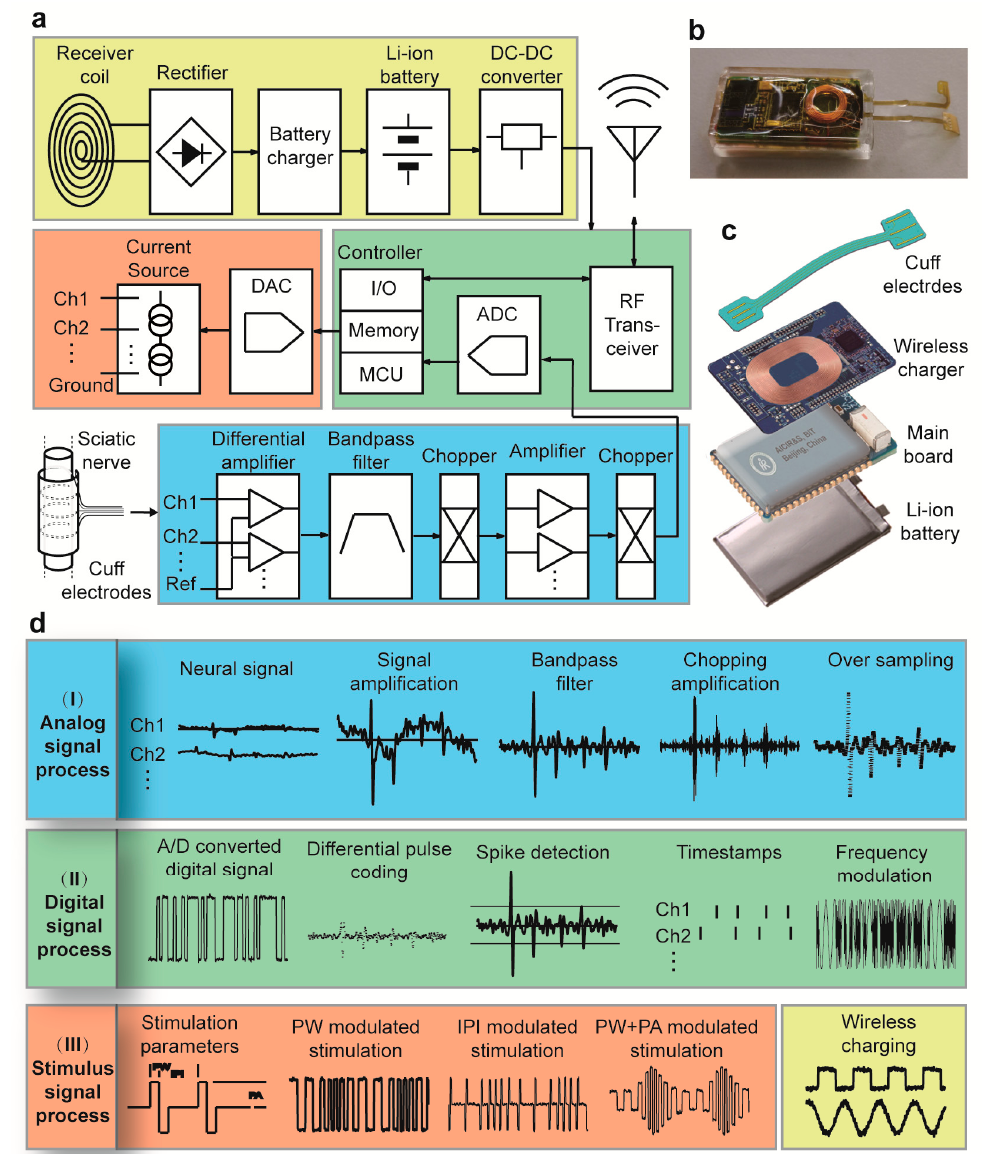
Figure 1. The system block diagram, photograph, 3D assembly, and signal processes of the implantable wireless neural interface microsystem (Neurobits). ( a ) The system block diagram of Neurobits, which consists of an analog signal acquisition unit, a digital signal process unit, a stimulation unit, and a wireless charger. ( b ) Photo of Neurobits. ( c ) Three-dimensional view of the system assembly, consisting of a cuff electrodes array, a wireless charger board, a main board, and a Li-ion battery. ( d ) Diagram showing how different signals are processed inside Neurobits (I, II, III). (I) In analog signal processes, the neural signal from electrodes is amplified and band-pass filtered before passing through a chopper amplifier to reduce internal offset voltage and low-frequency noise. Finally, the analog signal is oversampled to decrease noise and converted into a digital version. (II) In digital signal processes, the signal is encoded using the differential pulse coding method to reduce bit flow. Neurobits is also capable of detecting neural spikes and recording their timestamps. The coded raw signal or spike timestamps are wirelessly sent out through the RF transceiver using the frequency modulation method. (III) In stimulus signal processes, stimulation parameters are remotely set and sent wirelessly to Neurobits, which generates three different types of stimuli according to these parameters, i.e., pulse width-modulated stimuli (PWMS), interpulse interval-modulated stimuli (IPIMS), and pulse width plus pulse amplitude-modulated stimuli (PW+PAMS).